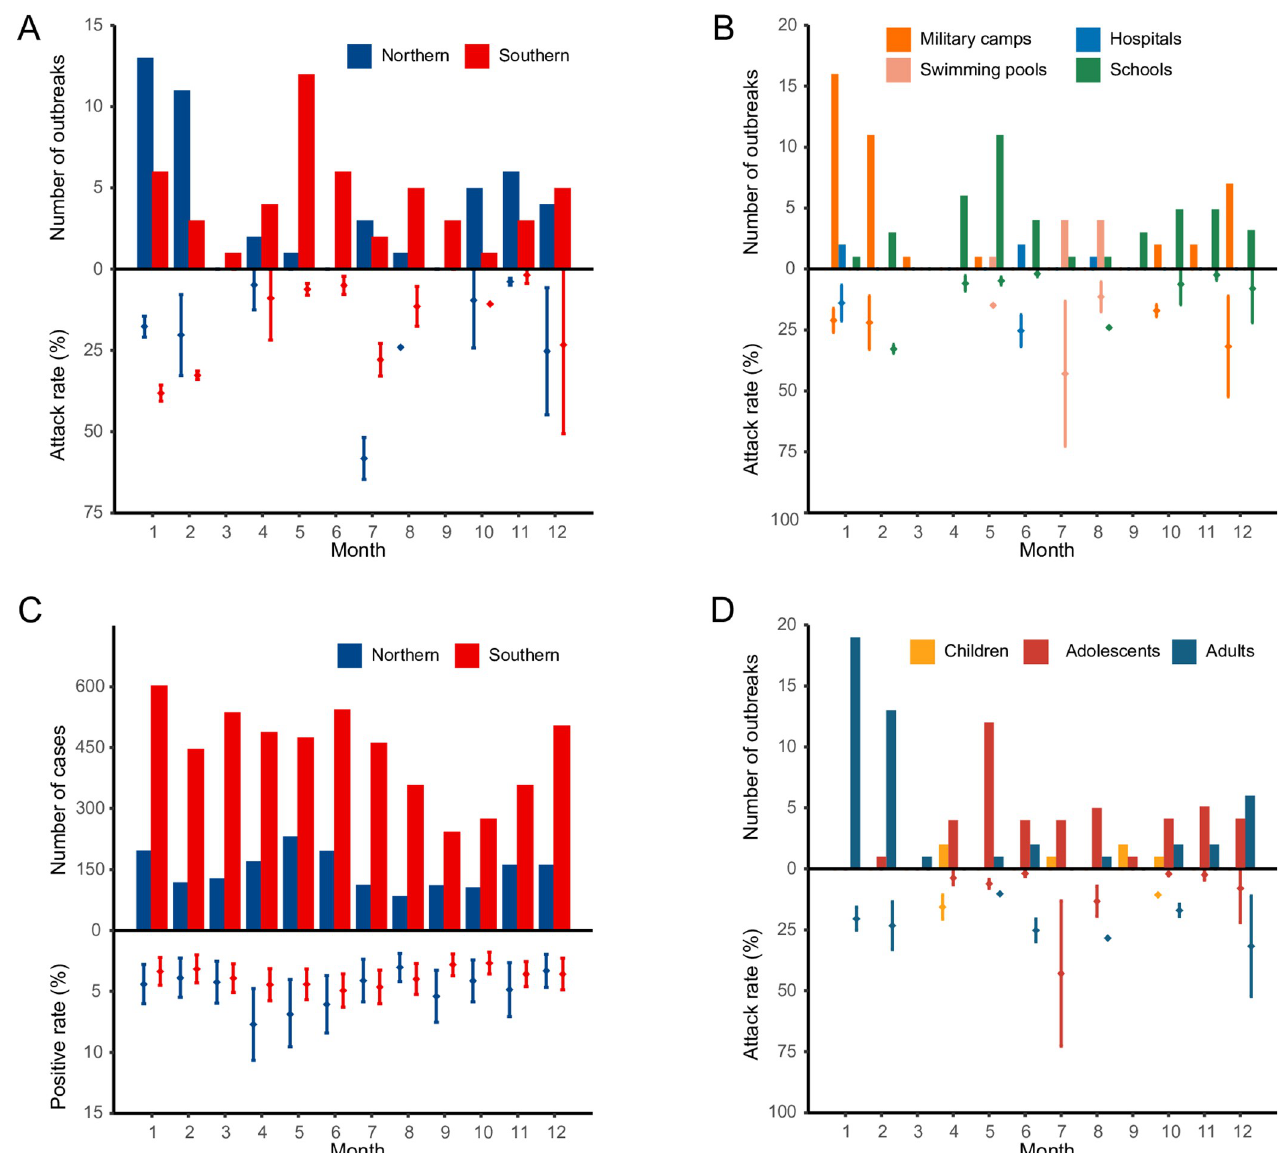
Fig 3. Attack rate of HAdV in outbreaks and positive detection rate of HAdV in etiological surveillance over months based on the meta-analysis. (A) attack rate by region; (B) attack rate by settings; (C) positive detection rate by regions; (D) attack rate by age groups. The bars in panels A, B, and D indicate the number of outbreaks, and the intervals indicate the attack rate and 95% CI. The bars on panel C indicate the case number in etiological surveillance, and the intervals indicate the positive detection rate and 95% CI.